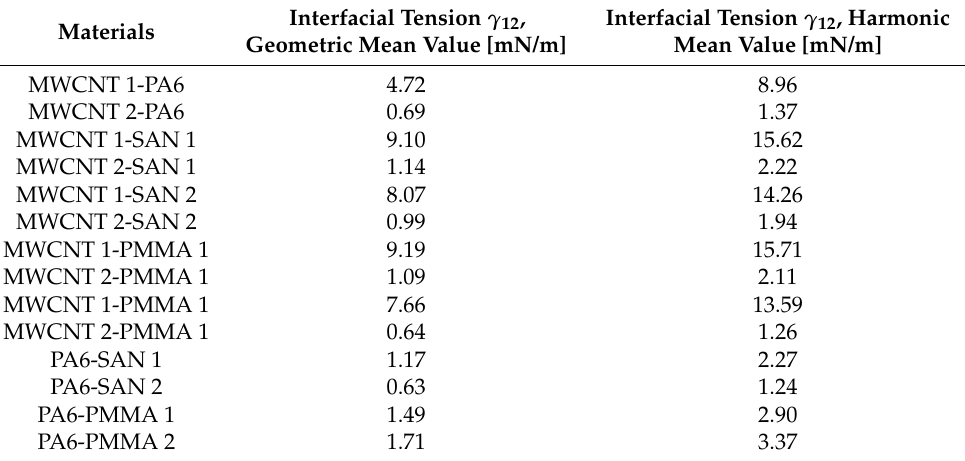
Table 4. Interfacial tensions as calculated using harmonic and geometric mean equations and values given in Table